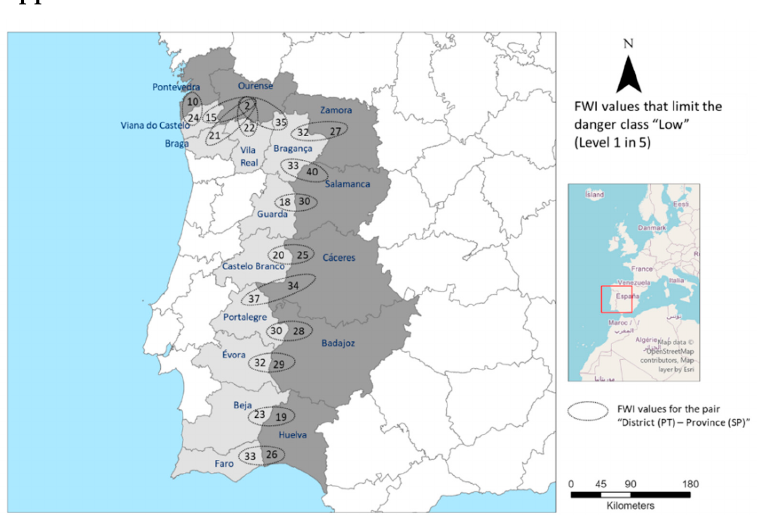
Figure A12. Final proposal of the threshold FWI values for each pair of District in Portugal (PT) and Province and Spain (SP)—Class “Low” (Level 1 of 5).